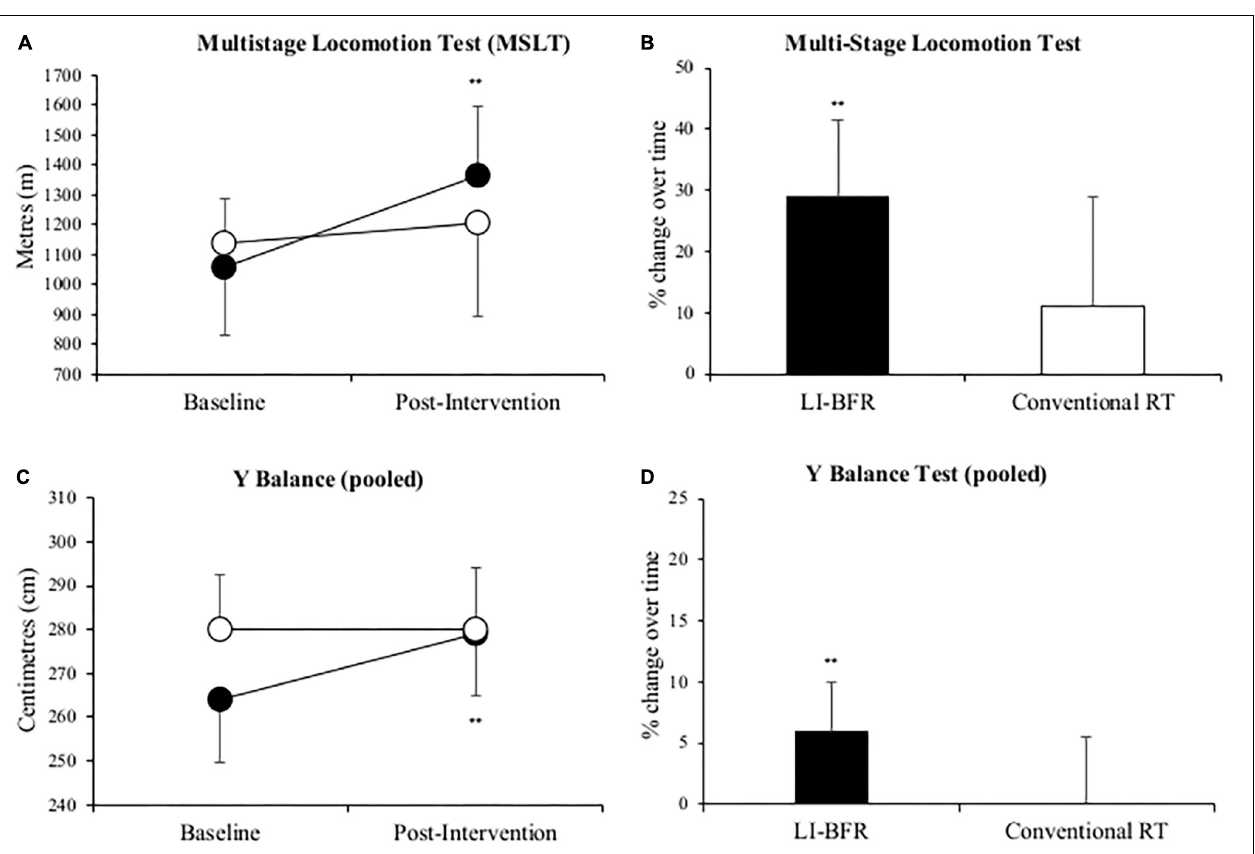
FIGURE 4 | Changes in multi-stage locomotion test (MSLT) (A,B) , and pooled Y balance (C,D) at baseline and after 3-weeks of rehabilitation. Black points LL-BFR group, White points Conventional Resistance Training (RT) group. Bar charts show group percent changes over time. Data is expressed as mean ± SD. ∗ p < 0.05 and ∗∗ p < 0.01 versus baseline measurement. Data refers to primary injured limb. LL-BFR, low-load blood flow restriction; RT, resistance